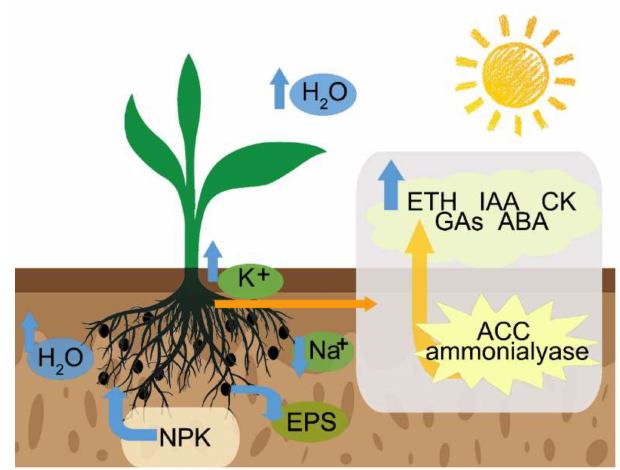
Figure 2. Mechanism of PGPR in salt stress alleviation. Black circles surrounding the roots represent the PGPR. Under salt stress, plants reduce transpiration and water loss by increasing K + absorption and reducing Na + absorption, thus alleviating osmotic stress and ion stress; PGPR promote plant growth by increasing nutrient absorption; meanwhile, PGPR regulate hormone production (IAA, GAs, CK, and ABA) and ACC deaminase activity to alleviate salt stress. Exopolysaccharides (EPSs) are homologous or heteropolysaccharides produced by rhizosphere bacteria. EPSs bind soil particles into aggregates to form a closed substrate that increases root adhesion to the soil (RAS/RT) in each root tissue, giving protection from environmental fluctuations. Protective EPS capsules have a strong water retention capacity, protecting plants from desiccation under salt stress, as well as help plants to absorb